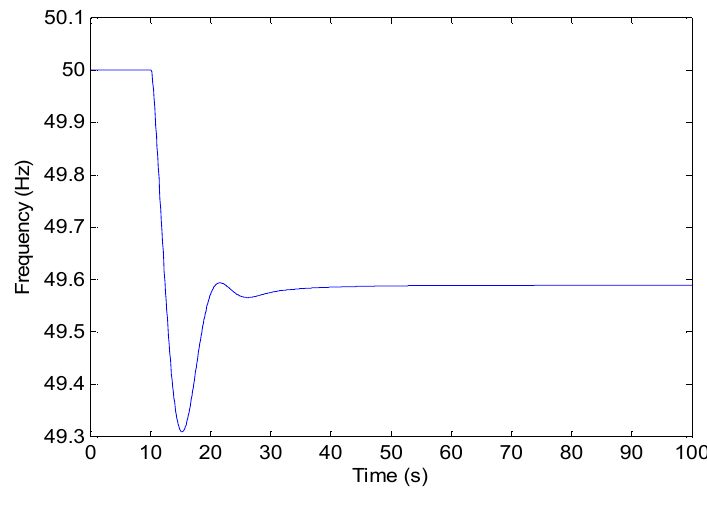
Figure 9. Frequency signal for